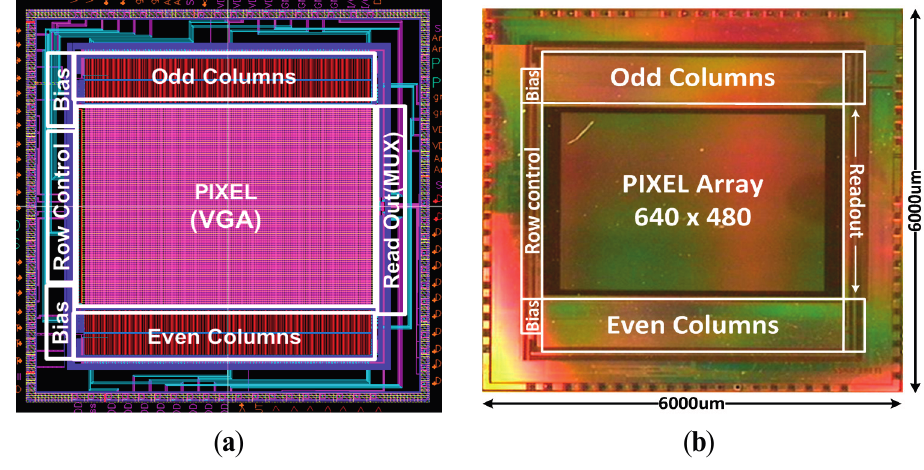
Figure 9. Chip Layout and Microphotograph the CIS with Samsung 0.13 µm CIS technology: ( a ) Chip Layout of the CIS with VGA resolution ( b ) chip